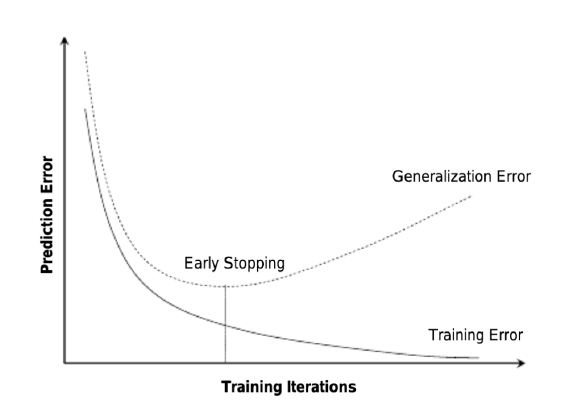
Figure 3. Learning curve showing generalization and training error versus training iterations (Perlich, 2010)